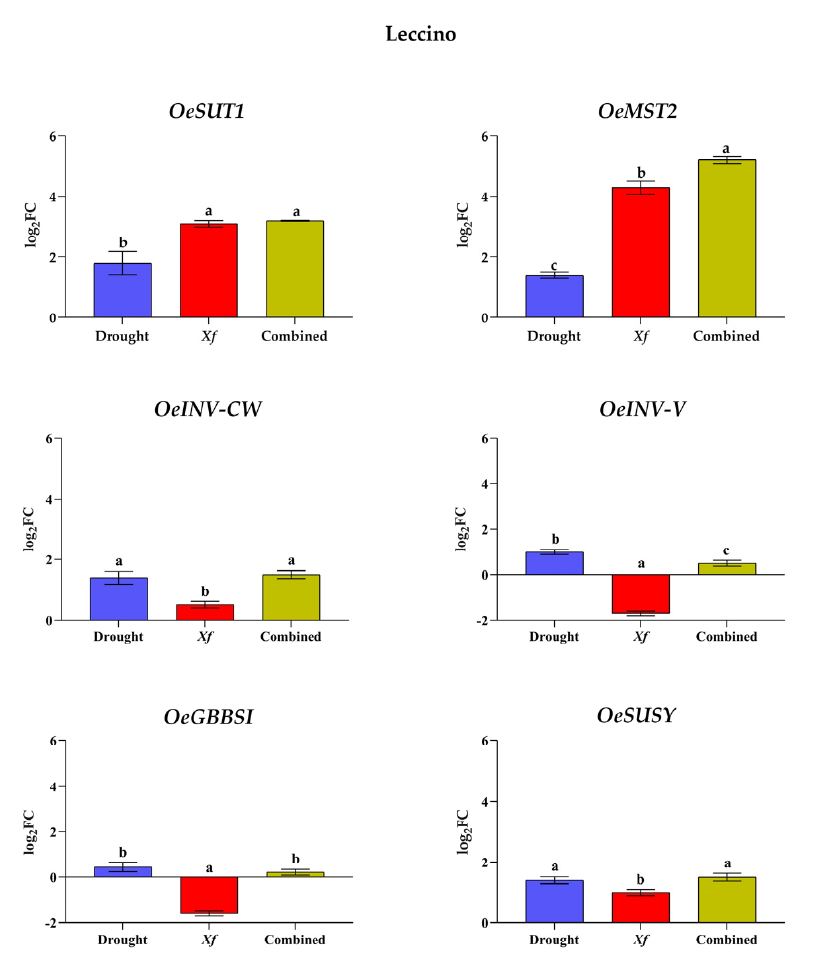
Figure 4. Expression analysis genes involved in sugar metabolism and transport in leaves of Leccino cultivar subjected to stresses: drought, pathogen Xylella fastidiosa , and a combination of both, expressed as log 2 fold change (log 2 FC) relative to controls. Quantitative analyses of expression of genes coding for the sucrose transporter ( OeSUT1 ); the monosaccharide transporter ( OeMST2) ; the cell wall invertase ( OeINV-CW ); the vacuolar invertase ( OeINV-V ); the granule-bound starch synthase I ( OeGBSSI ); the sucrose synthase ( OeSUSY ). Statistical analysis was carried out through one-way ANOVA with Tukey-HSD post hoc test. Within cvs., different letters correspond to statistically different means.